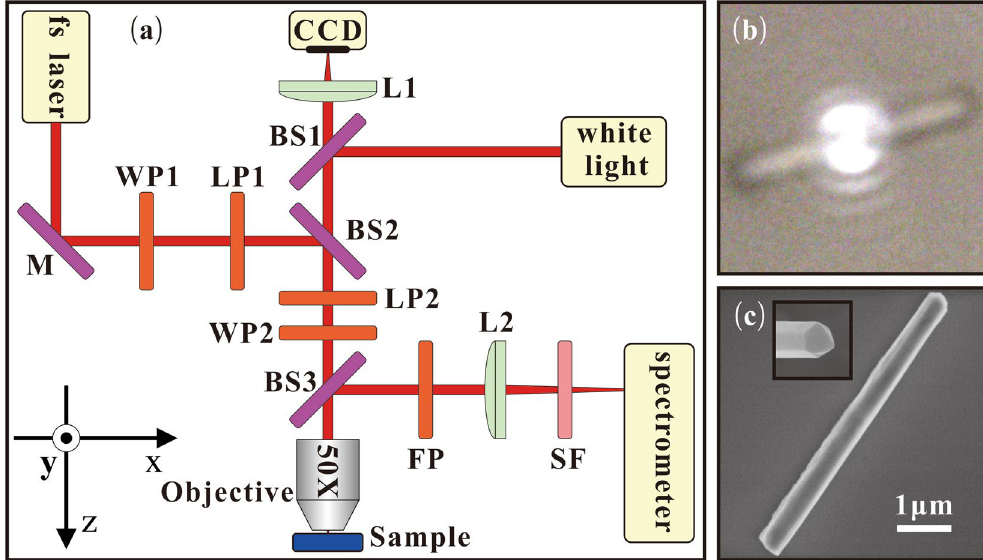
Figure 1. ( a ) Schematic diagram showing the experimental setup used to measure SHG from a single GaAs NW. M: mirror; WP1, WP2: half-wave plates; LP1, LP2, FP: polarizers; BS1, BS2, BS3: beam splitters; L1, L2: lenses; SF: short-pass filter. ( b ) CCD image of a GaAs NW with the pump laser spot focused on it. ( c ) SEM image of single GaAs NW on a SiO 2 substrate, where the NW has a diameter of approximately 500 nm and length of approximately 5.55 μ m. The inset shows the hexagonal NW